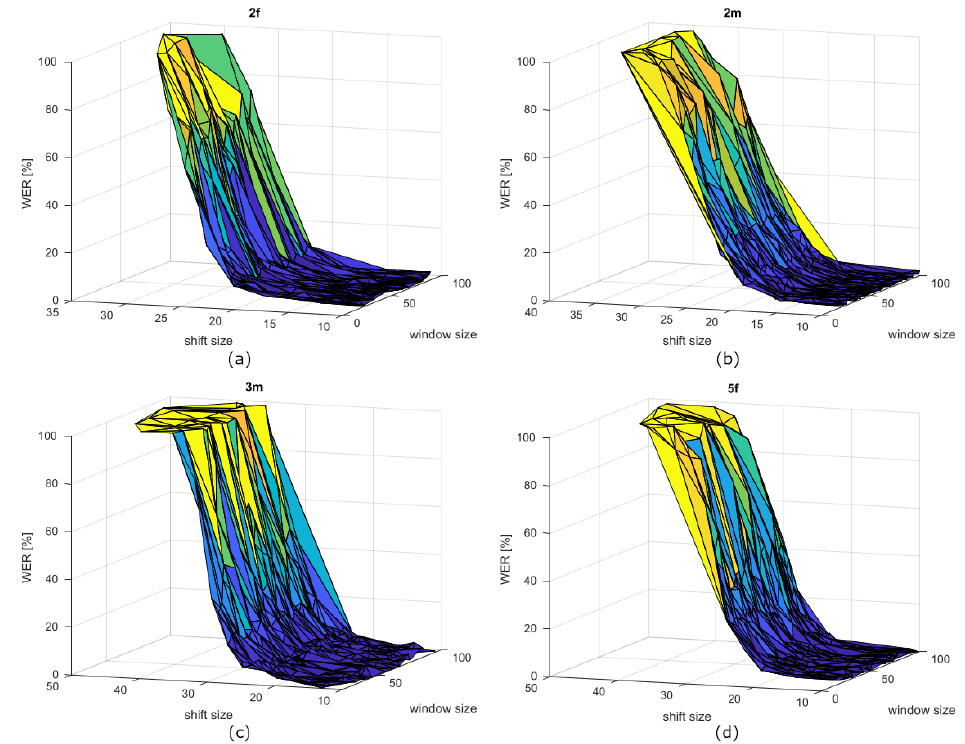
Figure 4. WER curves of speakers ( a ) 2f, ( b ) 2m, ( c ) 3m, and ( d ) 5f depending on window and shift